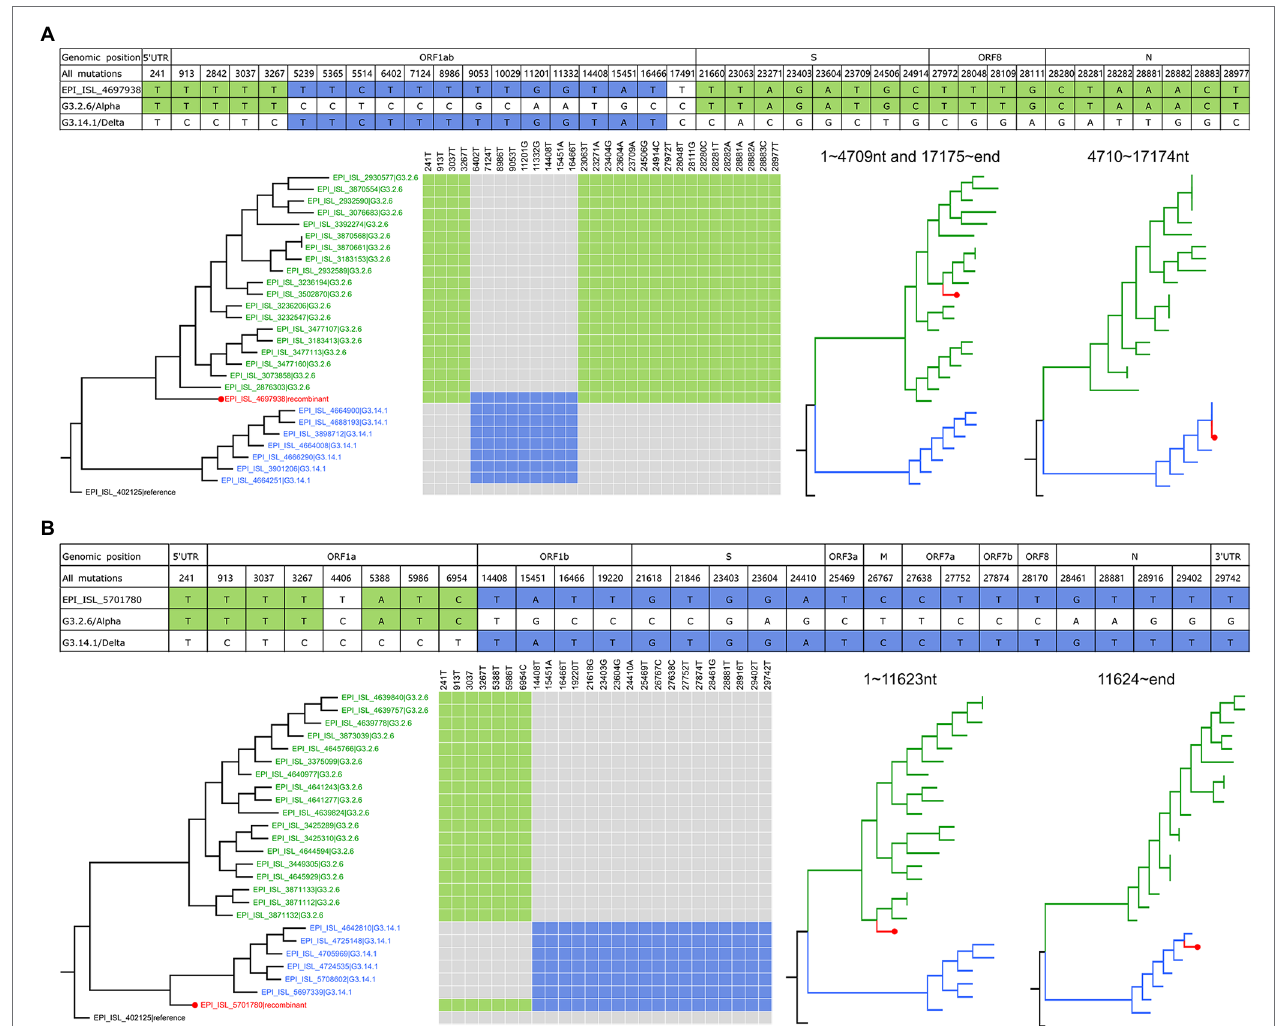
FIGURE 3 | The recombination events hosted by G3.2.6/Alpha and G3.14.1/Delta. (A) Genetic recombination in EPI_ISL_4697938. All the mutations of EPI_ ISL_4697938 and their positions in the genome are listed, in which nucleotides same with G3.2.6 are shaded in green, and nucleotides same with G3.14.1 are shaded in blue. The phylogenetic tree of whole genomes including EPI_ISL_4697938 and the representative parental sequences is on the left. The co-mutations in the recombinant genome are marked with color and are mapped on the parental sequences. The phylogenetic trees of the recombinant region and non- recombinant region are on the right. (B) Genetic recombination in EPI_ISL_5701780. Refer to the legends in (A)